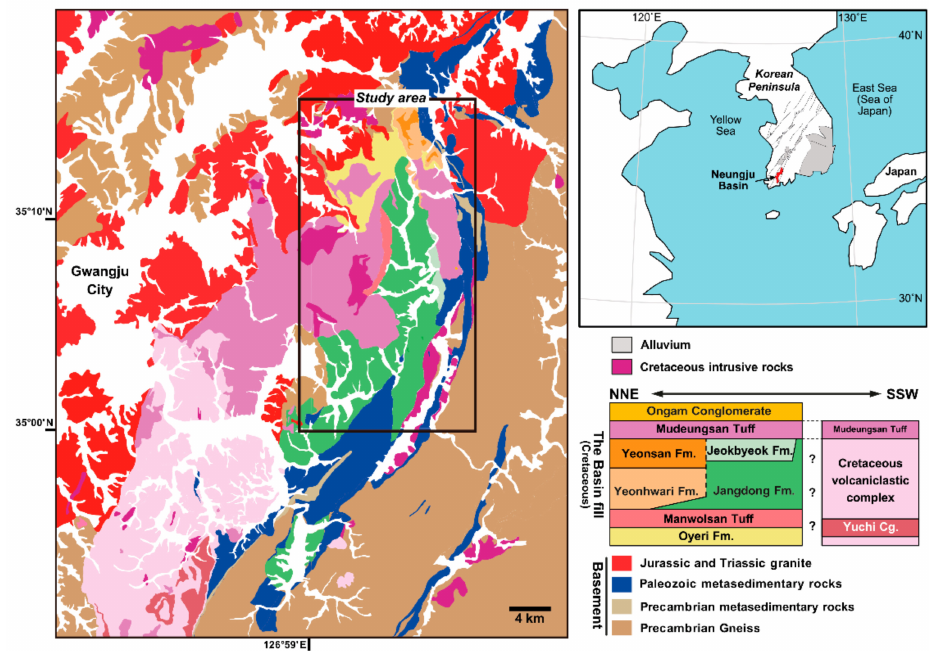
Figure 1. Geological map and stratigraphy of the Neungju Basin (modified after [19–25]). Precambrian granitic gneiss complexes broadly surround the basin. Paleozoic metasedimentary rocks are narrowly distributed along the eastern and southeastern basin margins. Triassic to Jurassic granites are mostly distributed on the northern and western side of the basin. In contrast to the northern part of the basin where epiclastic sediments were mainly deposited, the southern part of the basin was filled with volcaniclastic deposits, forming a volcaniclastic